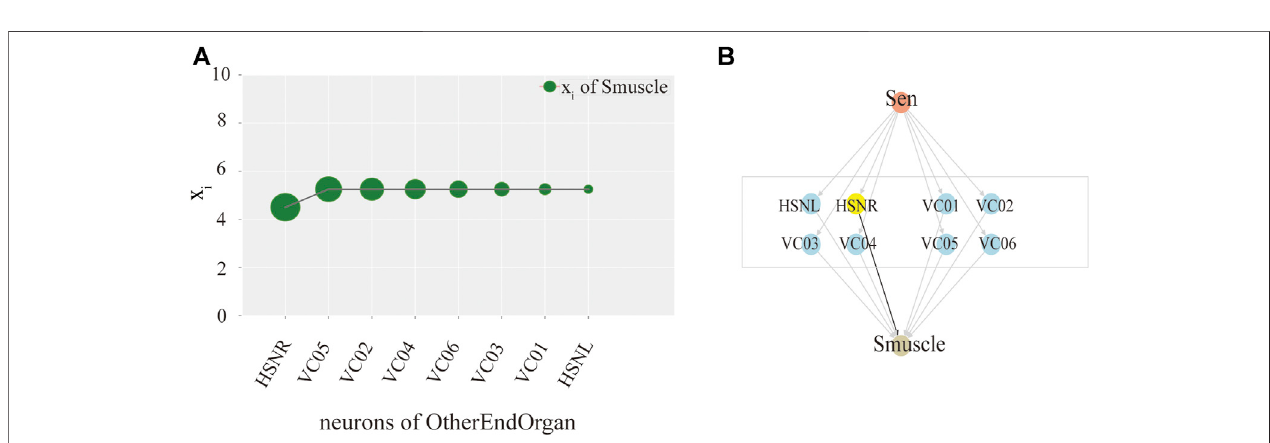
FIGURE 4 | Model exploration of single neuron hermaphroditism in C.elegans . (A) Activity line chart of SexSpec fi calCells-muscle, after neuronalperturbation of the SexSpec fi calCells-motor intermediate neuronal group in the hermaphroditism C.elegans by degree. (B) Control model of SexSpec fi calCells-muscle by the Interneuron group of SexSpec fi